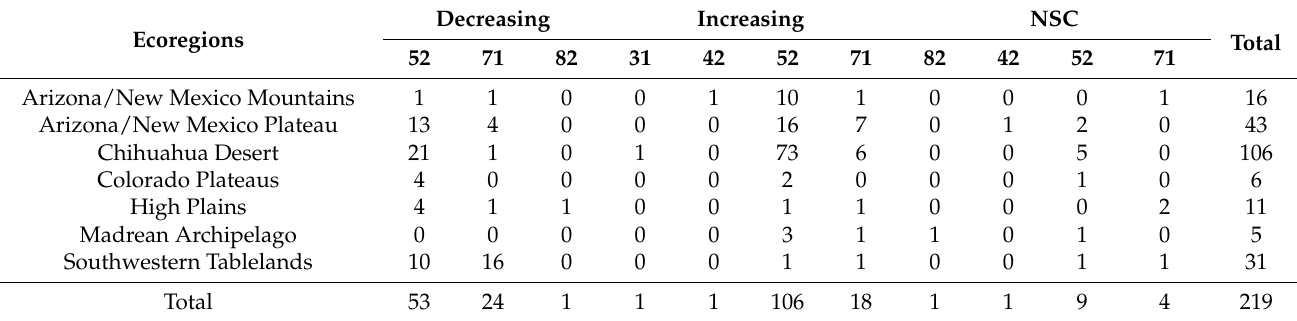
Table A1. Allocation of the randomly selected pixels as identified with Segmented VPR method over the different land cover classes based on the National Land Cover Dataset of 2011 (NLCD 2011) along the corresponding ecoregions. Ecoregions